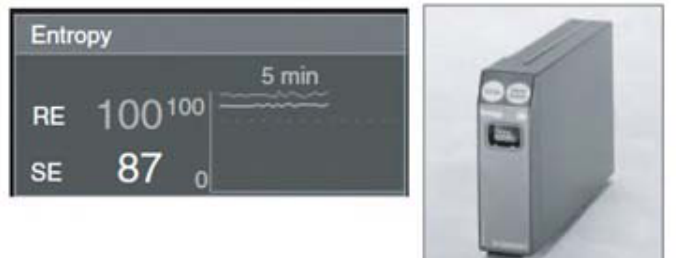
Figure 3. Entropy monitoring device and partial